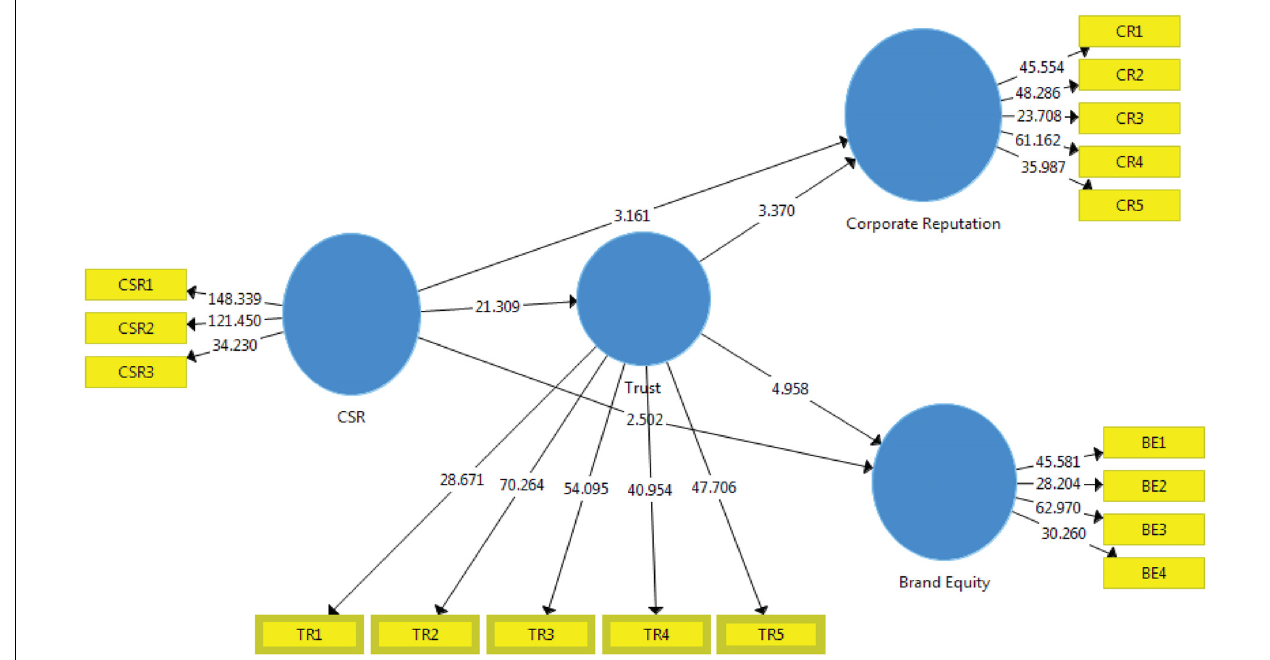
FIGURE 2 | Theoretical constructs with R2